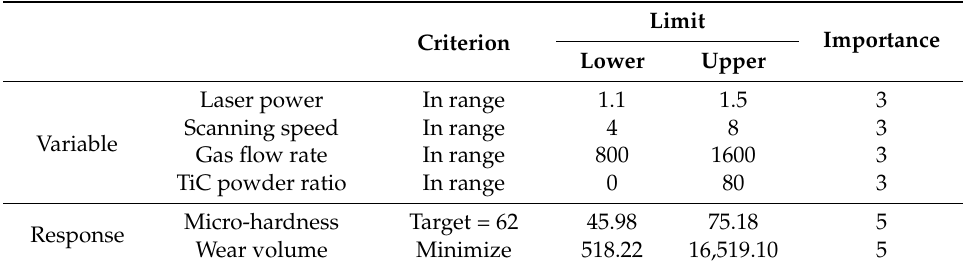
Table 7. Optimization criteria and limit.